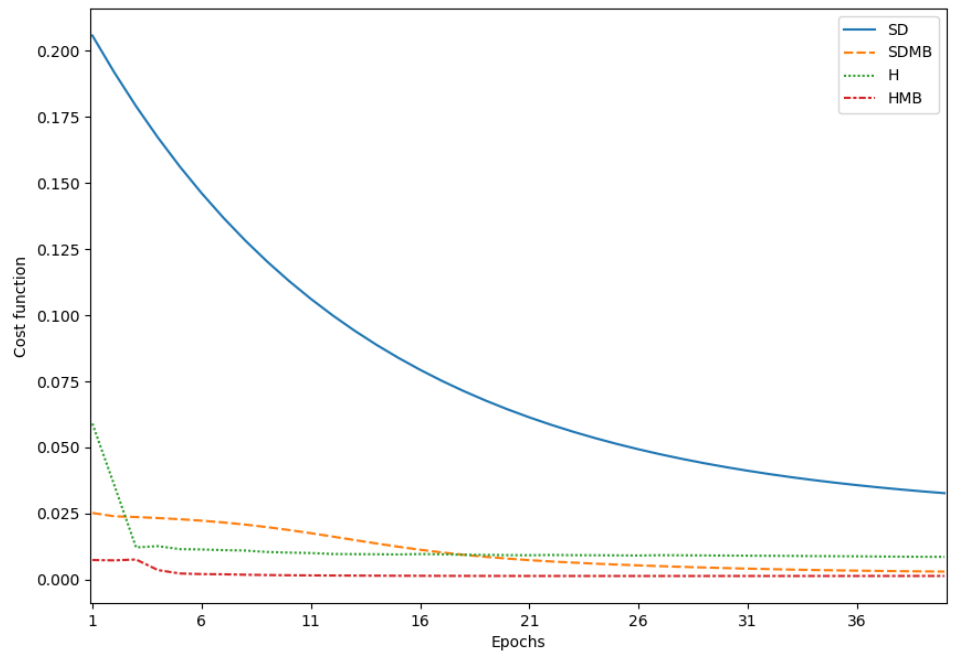
Figure 2. The cost maps during training, steepest descent (SD), steepest descent with mini-batches (SDMB), Hessian (H), Hessian with mini-batches (HMB).